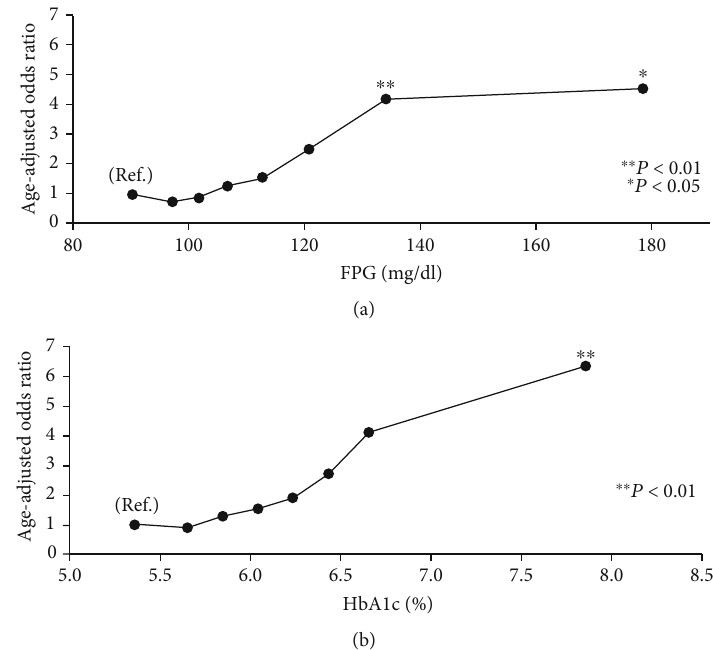
Figure 2: (a) The age-adjusted odds ratio of retinopathy according to the levels of FPG. The x -axis shows the average of each group. (b) The age-adjusted odds ratio of retinopathy according to the levels of HbA1c. The x -axis shows the average of each